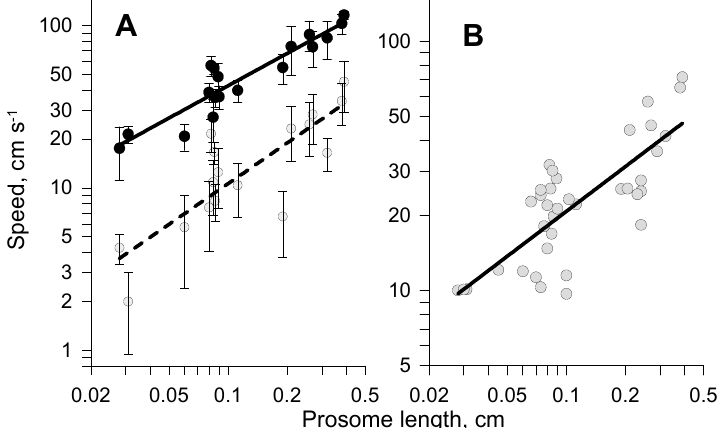
Figure 7. ( A ): Maximum ( ● ) and minimum ( ○ ) species-specific instantaneous speed in a continuous sequence of kicks of the escape reaction stimulated by electrical impulses; U max = 194.9 L 0.66 (R 2 = 0.87) and U min = 70.0 L 0.83 (R 2 = 0.70). ( B ): Mean speed of escape reaction stimulated by various impulses, including predatory fish (data from Table 3); U mean = 82.0 L 0.60 (R 2 = 0.62).